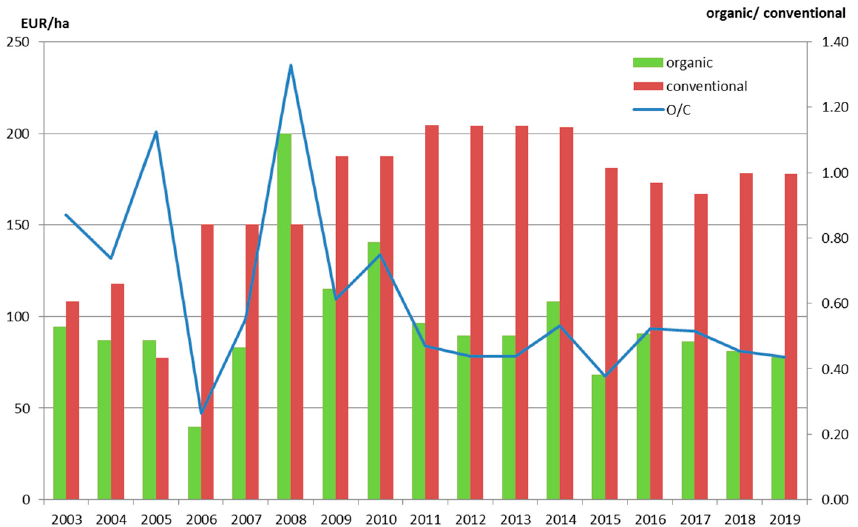
Figure 6. Energy consumption per hectare in non-ANC. (Source: [38], authors’ elaboration).